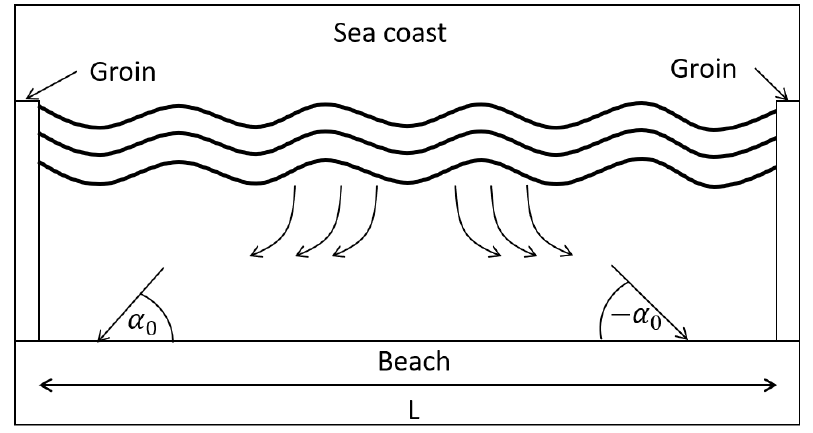
Figure 3. Initial